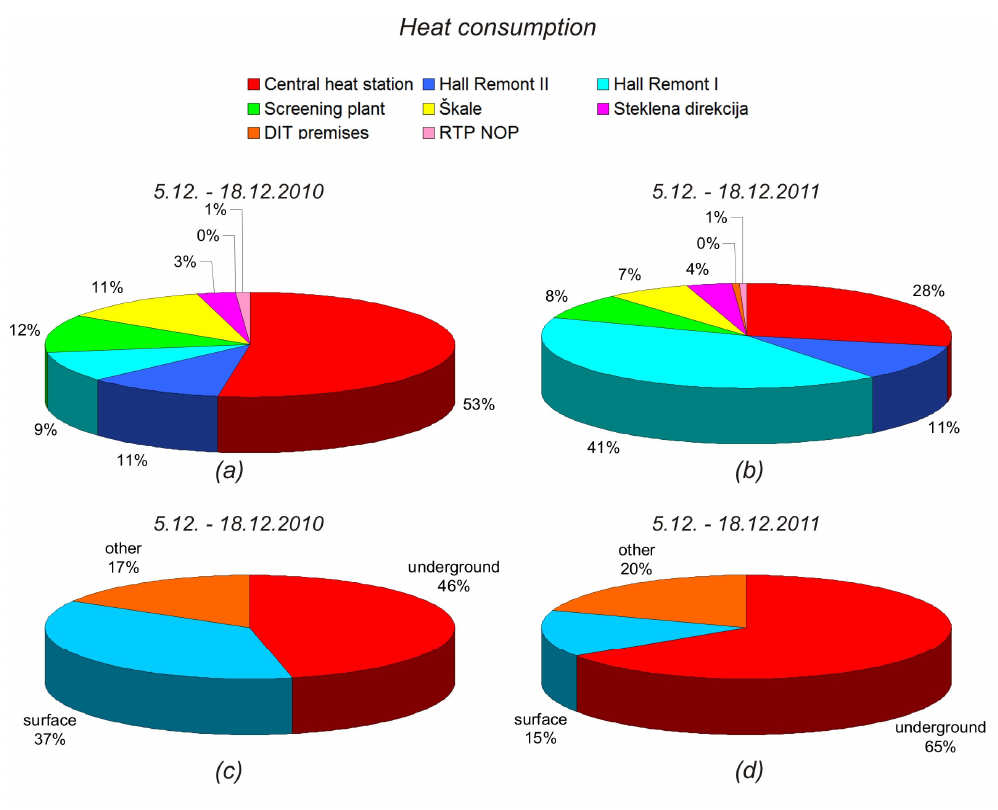
Figure 8. District heating consumption distribution in VCM for the month of December: ( a ) by different consumers in 2010; ( b ) by different consumers in 2011; ( c ) by location in 2010; ( d ) by location in